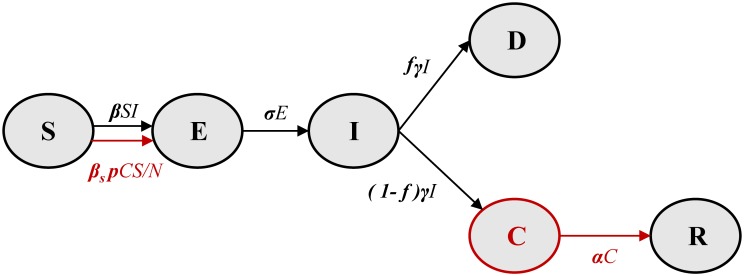
Schematic illustration of EVD transmission model including sexual transmission from convalescent patients.The elements in black form the base model without sexual transmission [12–14]. The red elements (convalescent individuals and additional transmission term) were added to account for sexual transmission.